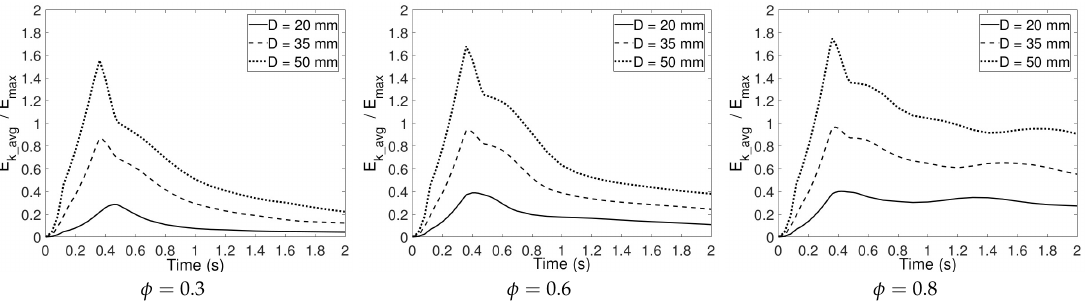
Figure 16. The effect of piston diameter on the kinetic energy of vortex